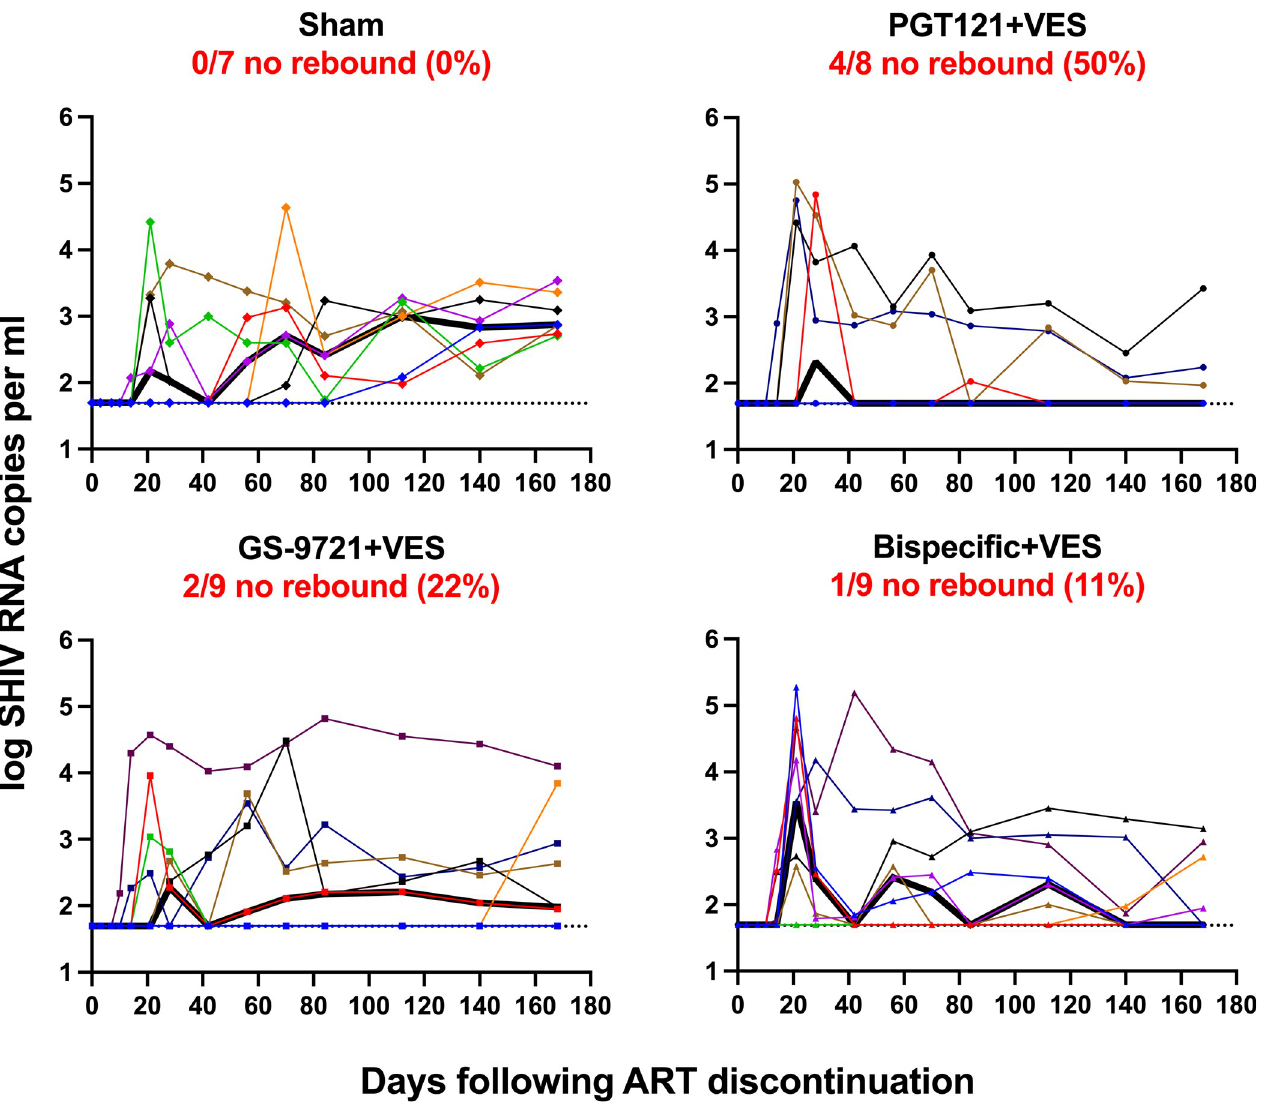
Fig 4. Viral loads following ART discontinuation. Plasma viral load for 168 days following ART discontinuation. Numbers and percentages of animals that did not show viral rebound are shown. In the PGT121+VES group 4 of 8 animals did not rebound (P = 0.05, Fisher’s exact test compared with sham group). In the GS-9721+VES group, 2 of 9 animals did not rebound (P = 0.30, Fisher’s exact test compared with sham group). In the bispecific+VES group, 1 of 9 animals did not rebound (P = 0.56, Fisher’s exact test compared with sham group). Dotted lines indicate limit of detection (1.7 log RNA copies per ml), values on the line were below limit of detection. Thick black lines indicate median viral load. Individual symbol and color coding as indicated in S1 Table.